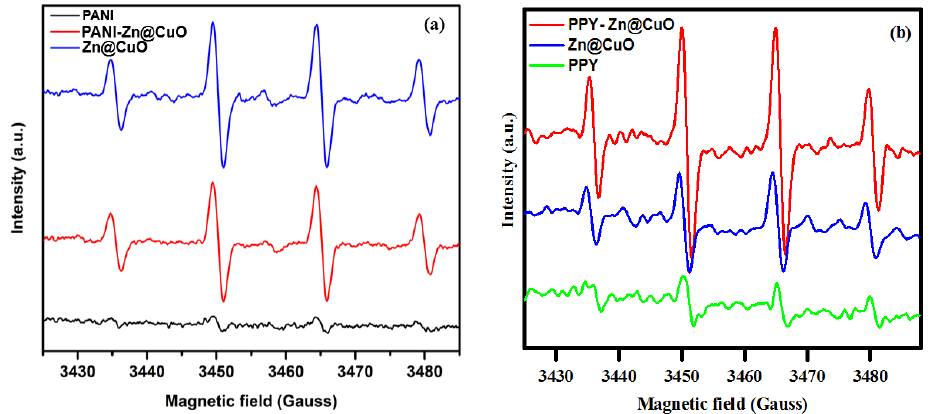
Figure 6. Electron paramagnetic resonance (EPR) measurement for ( a ) PANI-Zn@CuO and ( b ) PPY-